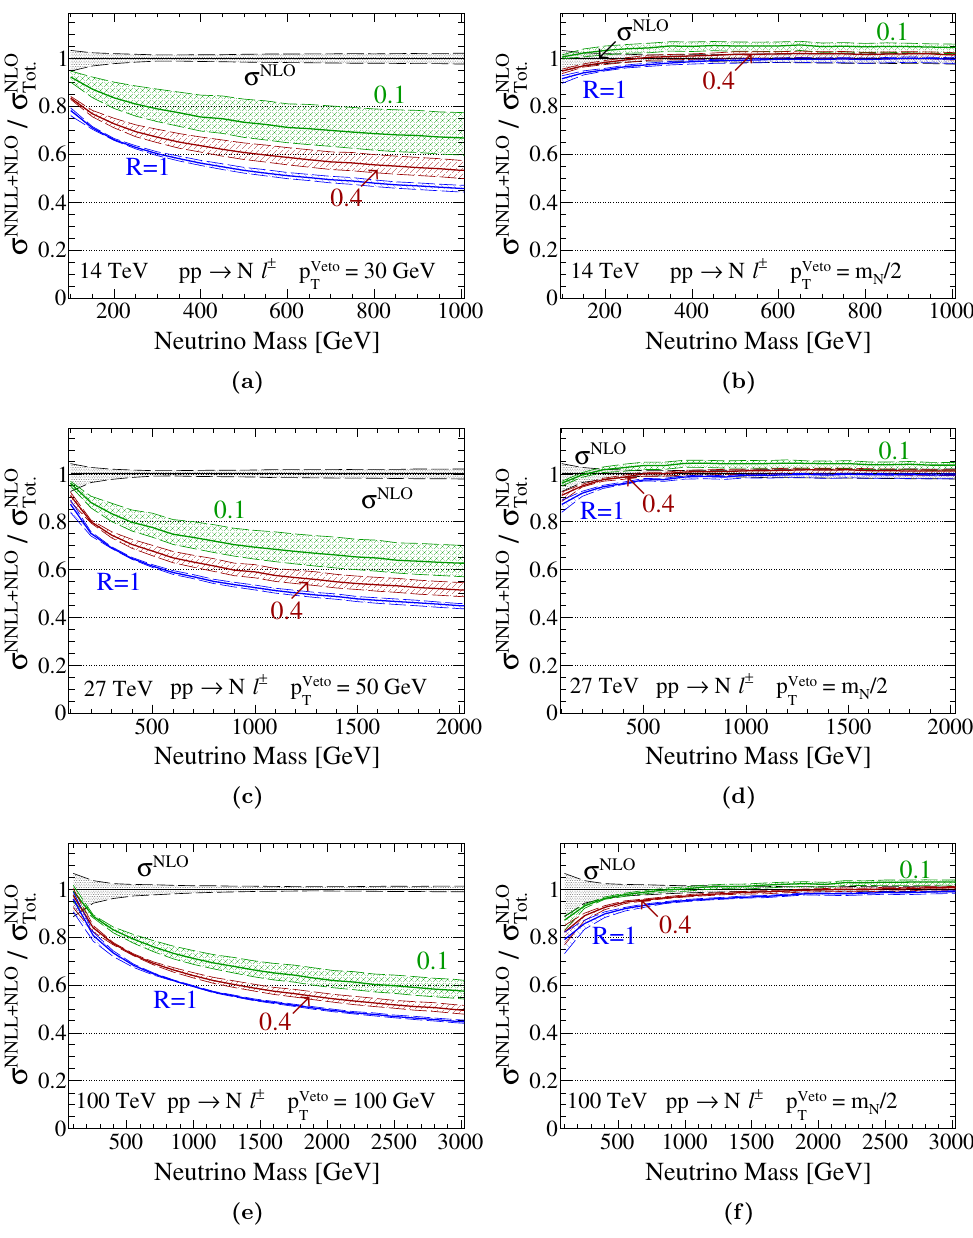
Figure 14. Jet veto e(cid:14)ciency at NLO+NNLL(veto) and residual scale dependence for the CC DY process pp N‘ , as a function of heavy neutrino mass for representative jet radii R , at (a,b) ! p s = 14, (c,d) 27, and (e,f) 100 TeV, assuming a static jet veto of (a) p Veto 100 GeV, and a representative dynamic veto of (b,d,f) m N =